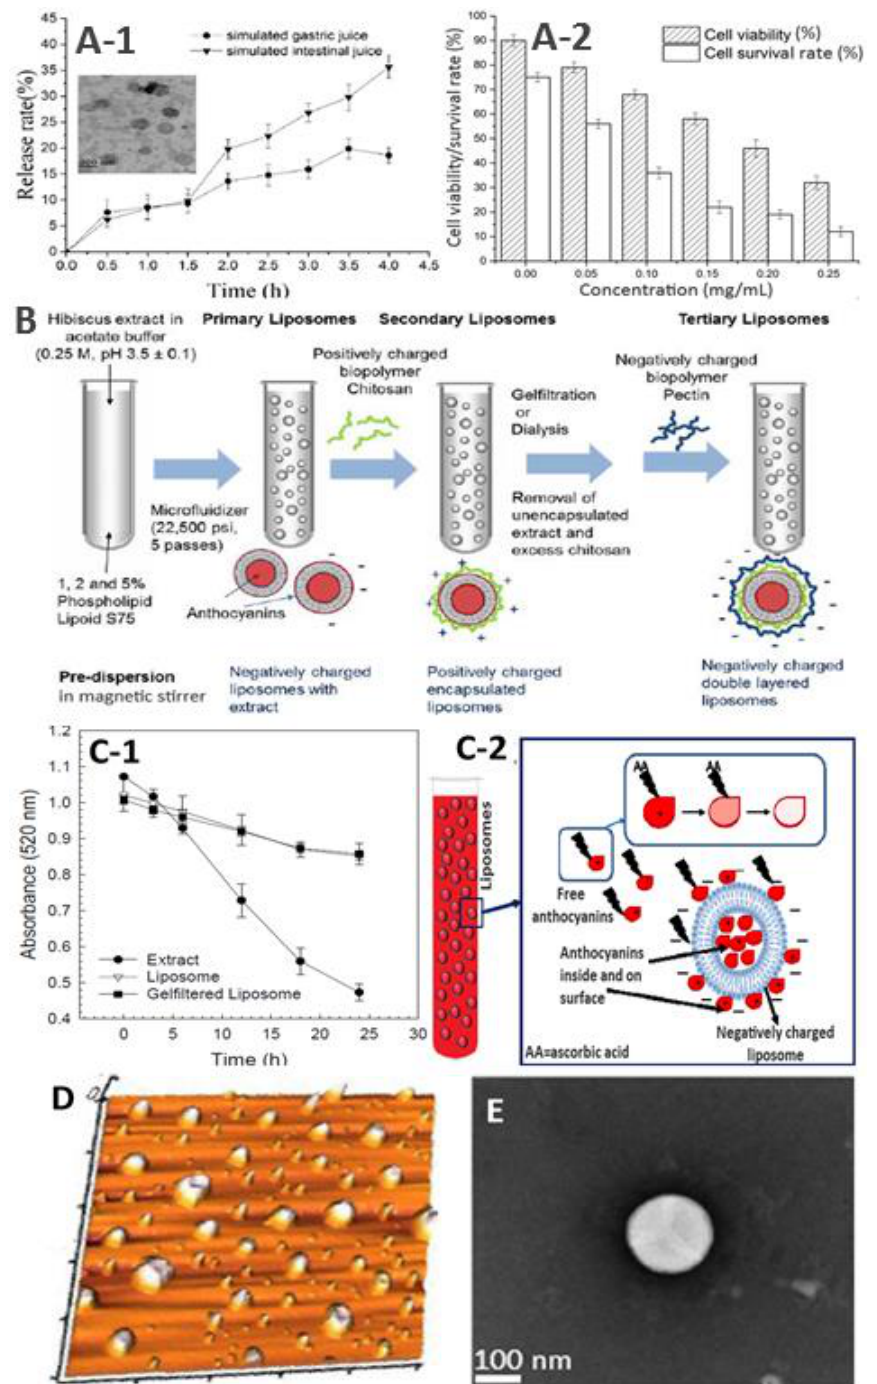
Figure 4. Different panels showing in vitro release rate ( A1 ) and absorption efficiency using the Caco-2 cell model ( A2 ) with the inset in A1 showing TEM image of cyanidin-3-glucoside nanoliposome, schematic representation of multilayered anthocyanin nanoliposome prepared from hibiscus ( B ), the physical stability of black carrot anthocyanin nanoliposome and extract in the presence of ascorbic acid ( C-1 ) along with the proposed mechanism of anthocyanin protection ( C-2 ), and atomic force microscopy (AFM) ( D ) and TEM ( E ) images of anthocyanin nanoliposomes prepared from pistachio hull and bilberry extracts, respectively (adapted with permission from references